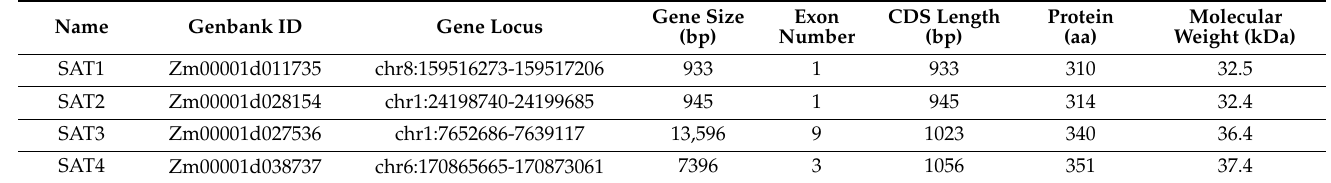
Table 1. Features of SAT members including gene locus, gene size and molecular